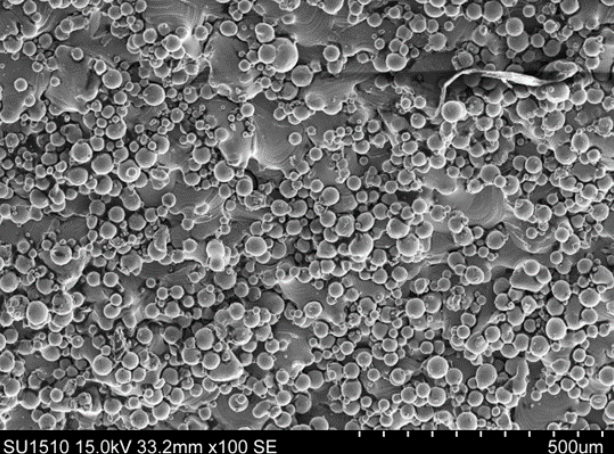
Figure 2. An electron microscopic image of sample E1 , before burnishing.